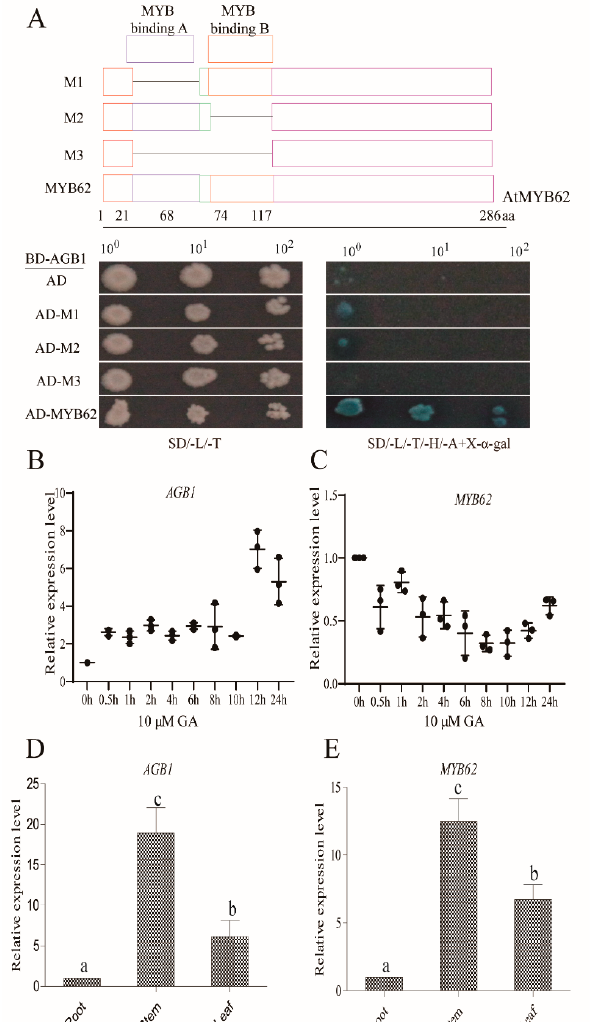
Figure 3. AGB1 and MYB62 expression analysis. ( A ) Yeast two-hybrid interactions between the full- length sequence of AGB1 and the piecewise sequence of MYB62. The transformed yeast cells were activated and cultured on SD/-Leu/-Trp and SD/-Leu/-Trp/-His/-Ade media. The yeast cells of the empty vectors AD and BD were used as negative controls. ( B ) Analysis of AGB1 expression in wild- type Col-0 leaves grown for 4 weeks after treatment with 10 μ M GA3 at different time periods. The data are the average of three independent experiments, and the error bar represents the SE ( n = 3). Significant differences were analyzed using Duncan’s multiple range test ( p < 0.05). Relative quan- titative results were calculated by normalization using the control gene ACT2 (AT3G18780). ( C ) Analysis of MYB62 expression in wild-type Col-0 leaves, grown for 4 weeks after treatment with 10 μ M GA3 at different time periods. The data are the average of three independent experiments, and the error bar represents the SE ( n = 3). Significant differences were analyzed using Duncan’s multiple range test ( p < 0.05). ( D ) Analysis of AGB1 expression in the roots, stem, and leaves of wild-type Col-0 grown for 4 weeks under normal growth conditions. The data are the average of three inde- pendent experiments, and the error bar represents the SE ( n = 3). a, b c indicate significant differences. Significant differences were analyzed using Duncan’s multiple range test ( p < 0.05). ( E ) Analysis of MYB62 expression in the roots, stem, and leaves of wild-type Col-0 grown for 4 weeks under normal growth conditions. The data are the average of three independent experiments, and the error bar represents the SE ( n = 3). Significant differences were analyzed using Duncan’s multiple range test ( p < 0.05).